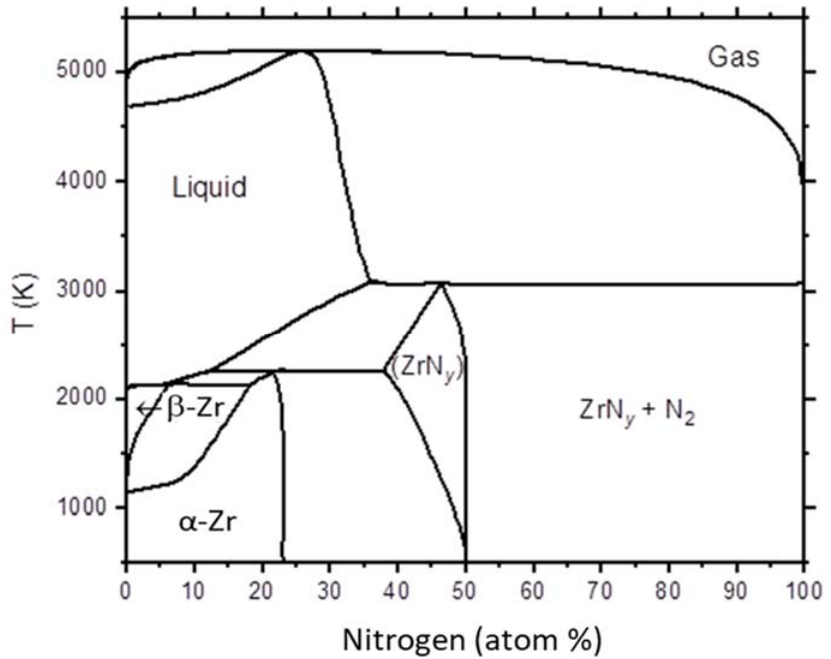
Figure 2. The calculated Zr–N phase diagram. Replotted from reference [16]. Raman characterization confirmed the ZrN phase formation after nitridation. Figure 3 plots the Raman spectra of the nitrided samples at various nitridation temperatures and time duration. All spectra feature multiple peaks at about 170, 220, and 514 cm − 1 . The two peaks at low frequencies, 179 and 232 cm − 1 , are characteristic transverse and longitudinal acoustic bands of ZrN, respectively, due to acoustic phonons [22]. The high-frequency peak at about 500 cm − 1 is caused by optical phonons in ZrN [22].